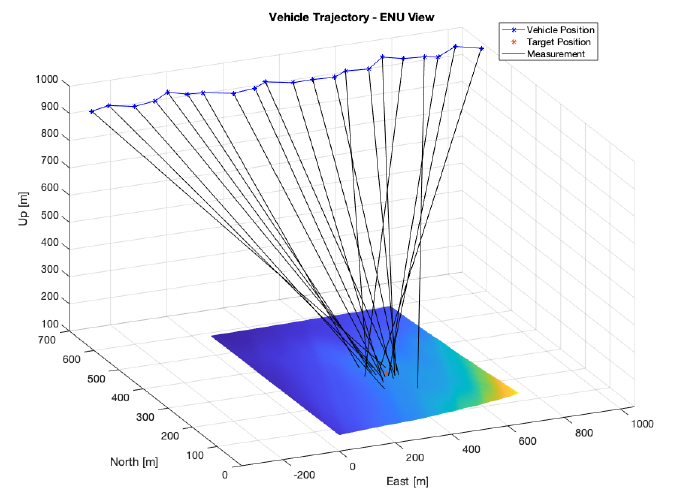
Figure 9. Measurements with noise-induced position and attitude on the flat terrain simulation.